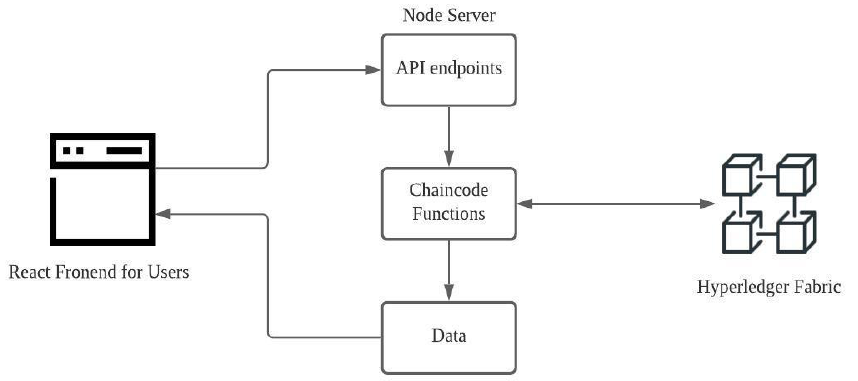
Figure 8. Interaction between the front end and the blockchain network.